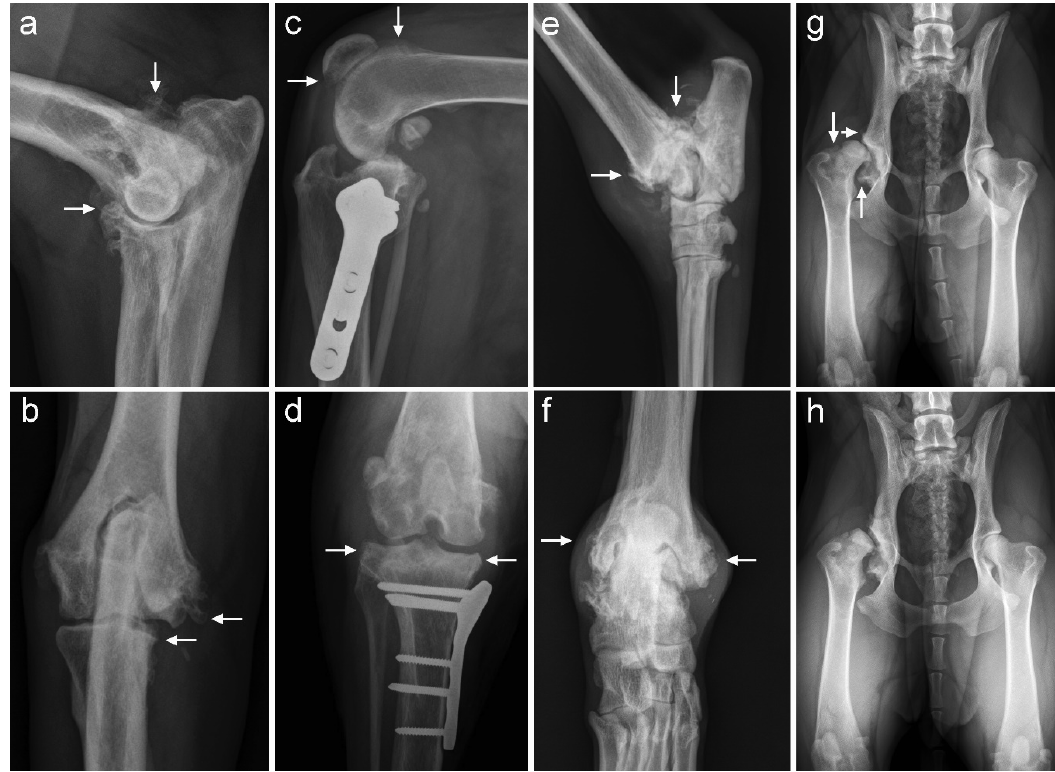
Figure 3. Representative examples of radiographs obtained 6 months after intra-articular injection with triamcinolone acetonide-loaded polyesteramide microspheres. Arrows indicate locations for osteophyte measurements. ( a , b ) Mediolateral and craniocaudal radiographs of the elbow joint of dog 6. ( c , d ) Mediolateral and caudocranial radiograph of the knee joint of dog 7. ( e , f ) Mediolateral and plantarodorsal radiographs of the tarsal joint of dog 5. ( g , h ) Ventrodorsal radiograph of the pelvis of dog 3 prior to and 6 months after treatment, respectively.